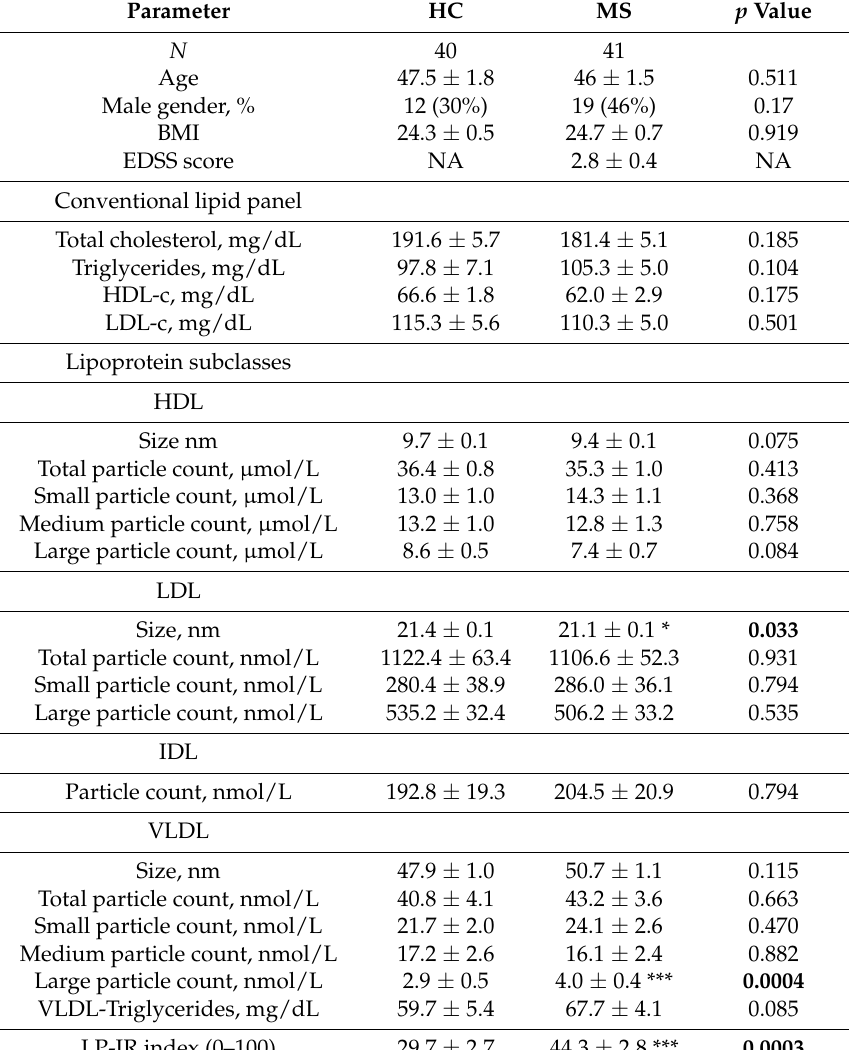
Table 1. Descriptive statistics and lipoprotein profile measurements for the study population at baseline.